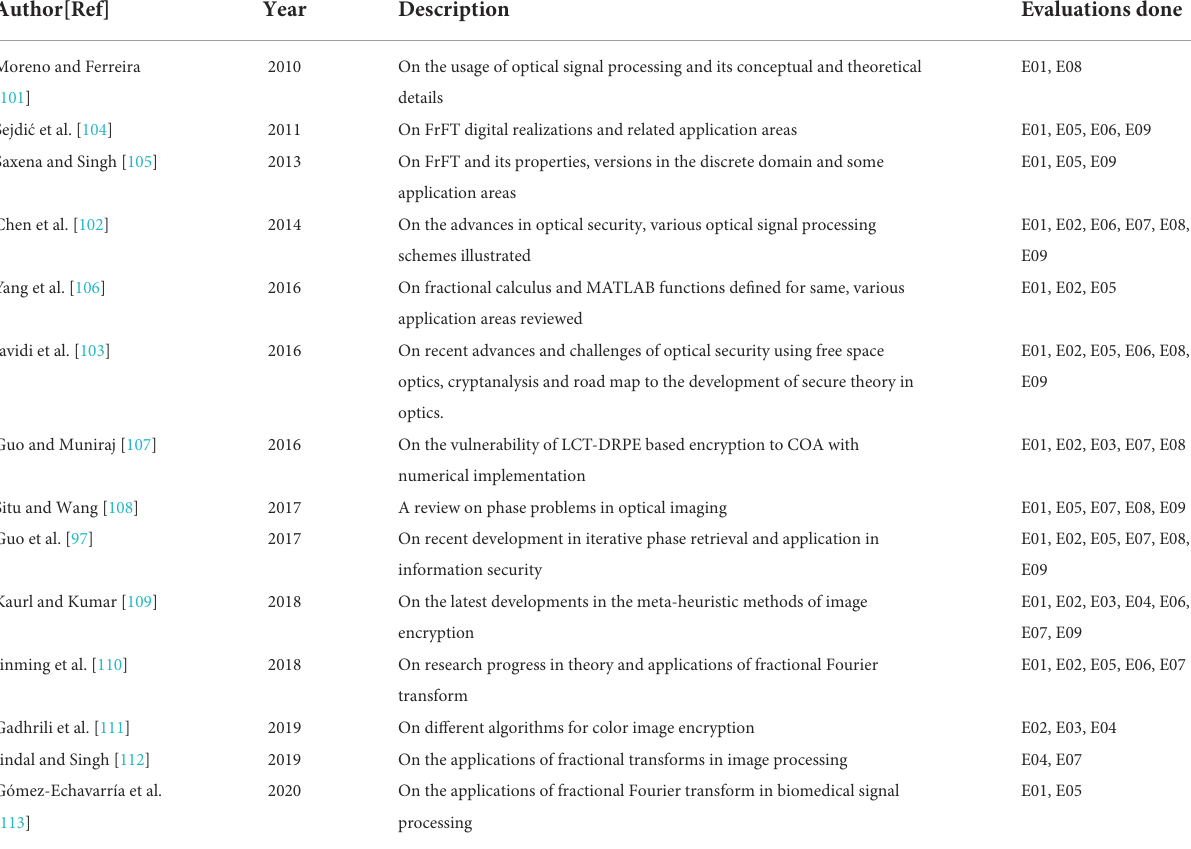
TABLE 2 Recent review articles on fractional transforms-based image encryption